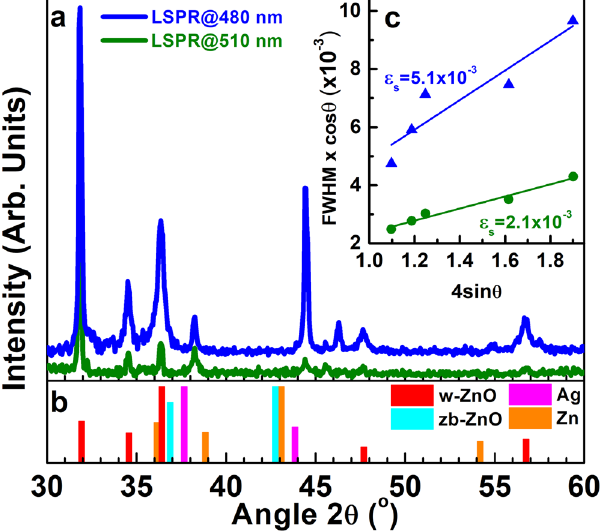
Figure 4. ( a ) XRD patterns of two pSi/ZnO samples fabricated using Ag NP templates of two different sizes and LSPR wavelengths (480 and 510 nm), ( b ) the powder diffraction reference patterns for w-ZnO, zb-ZnO, Ag and metallic Zn, ( c ) Williamson-Hall peak profile analysis for the determination of the micro-strain ε s, which is associated with the structural defect density.